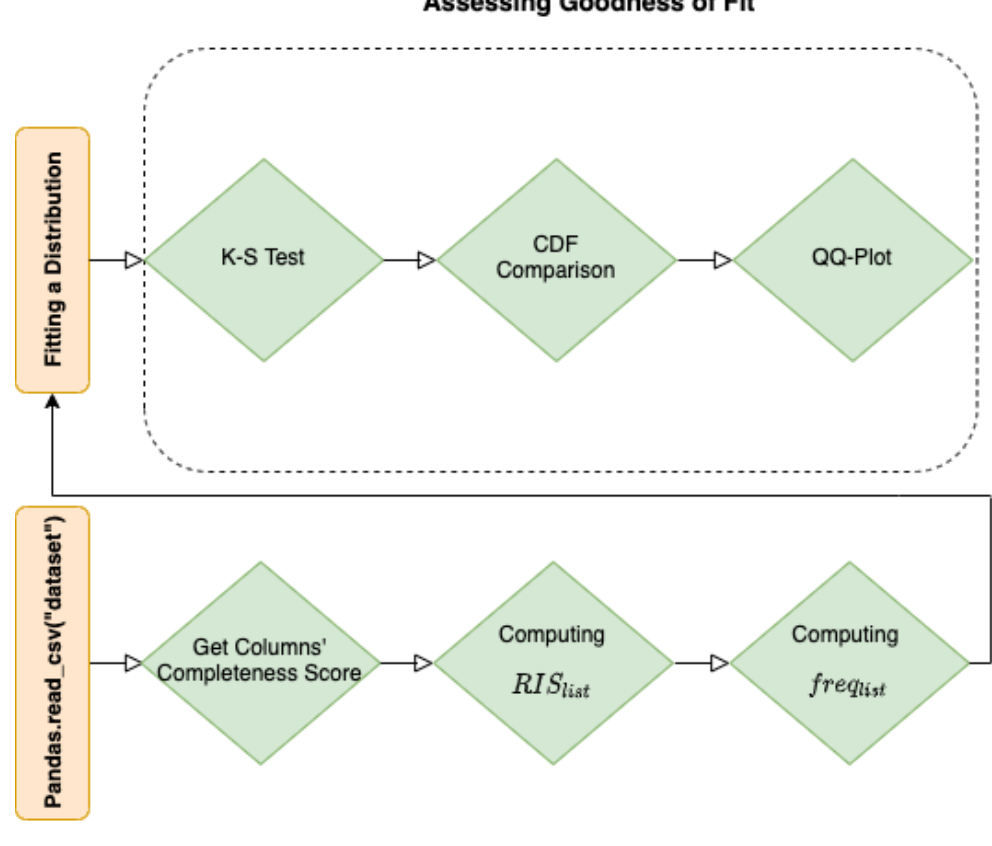
Figure 1. Algorithm